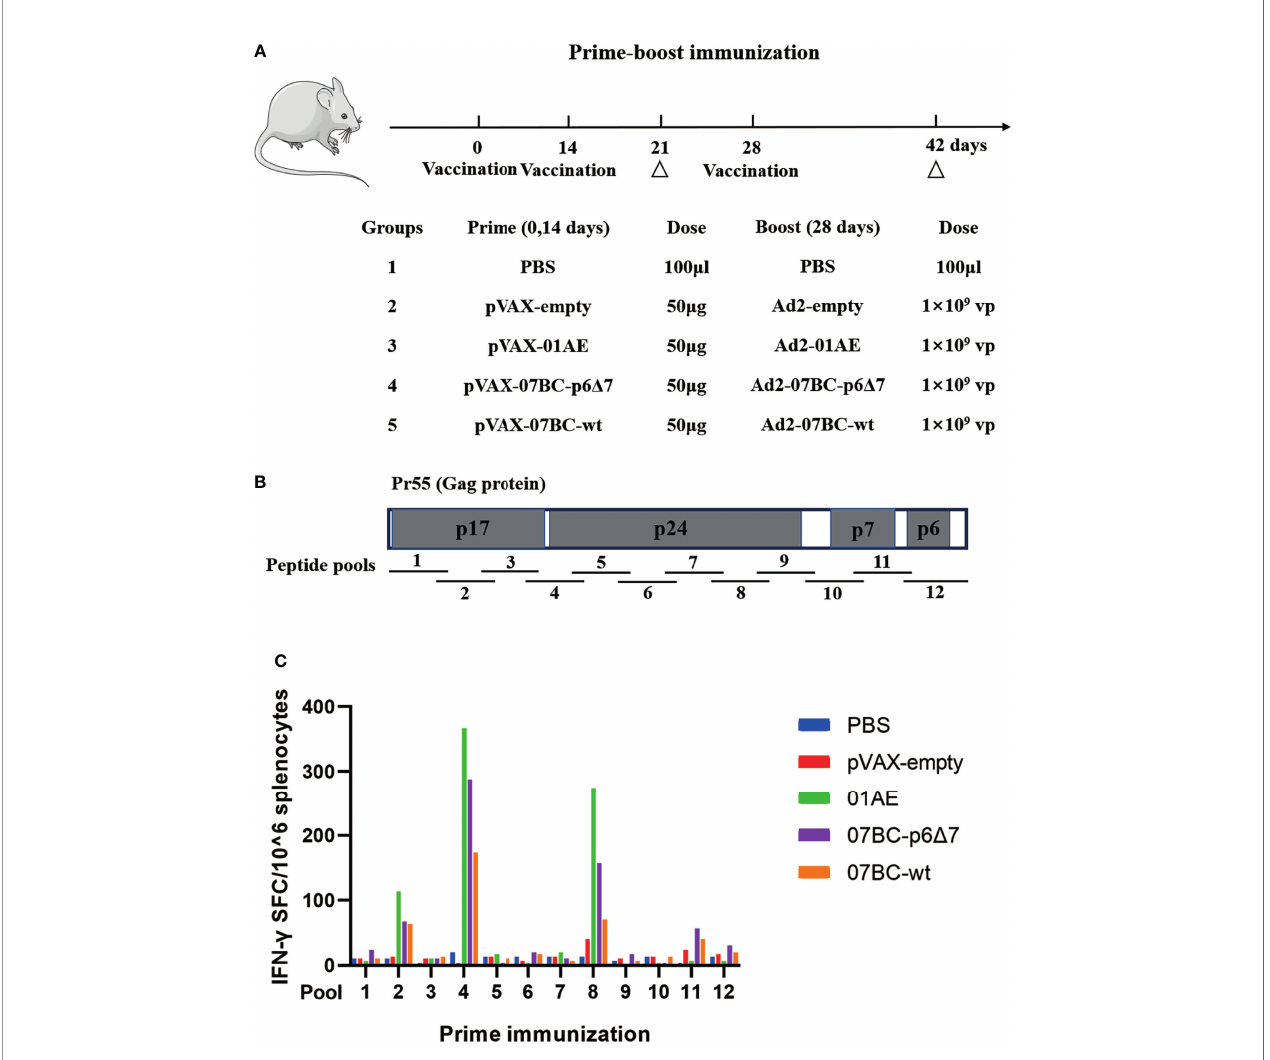
FIGURE 2 | Strong antigen-speci fi c IFN- g response against different regions of Gag protein after primary immunization in mice. (A) Vaccination strategy to evaluate the immunogenicity of various Gag proteins. Female BALB/c mice aged 6 – 8 weeks were randomly allocated into 5 groups (n = 10 per group). Each mouse was intramuscularly injected with 50 m g of the DNA plasmid dissolved in 100 m l of phosphate-buffered saline (PBS) at weeks 0 and 2 and then boosted intramuscularly with 1 × 10 9 vp of the corresponding adenoviral vector at weeks 4. Group PBS served as the negative control. “ D ” represents the time-point of sacri fi ce (5 mice per group) and sample collection. (B) The structure of Gag protein and the distribution of the peptide pools. Gag gene encodes HIV-1 viral core proteins including p17, p24, and p15. p15 is further cleaved into nucleocapsid proteins p7 and p6. The peptide pool was divided into 12 pools, each of which contained 10 peptides, and the last peptide pool contained 11 peptides. (C) Cellular immune responses of different peptide pools after primary immunization with DNA vaccine. The IFN- g ELISpot assay was used to detect the cellular immune response following stimulation with peptide pools after DNA-based vaccine immunization on day 21. Median responses (n = 5) in BALB/c mice following vaccination are shown by the number of spot-forming cells (SFCs) in one million splenic